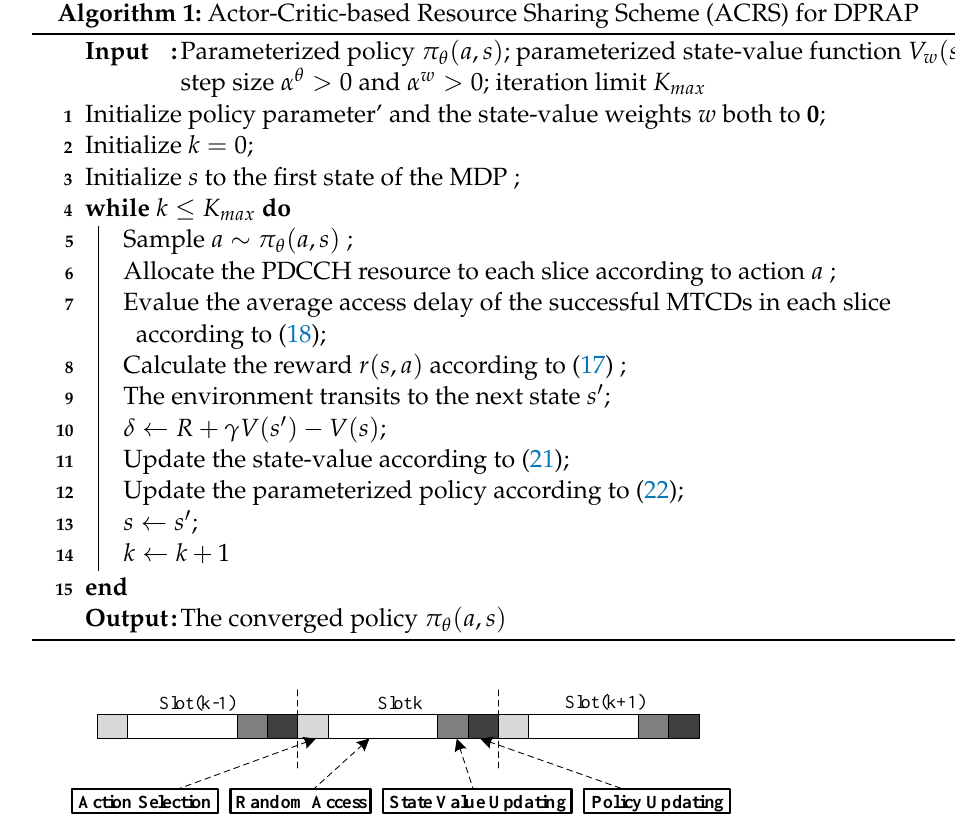
Figure 3. The procedure of